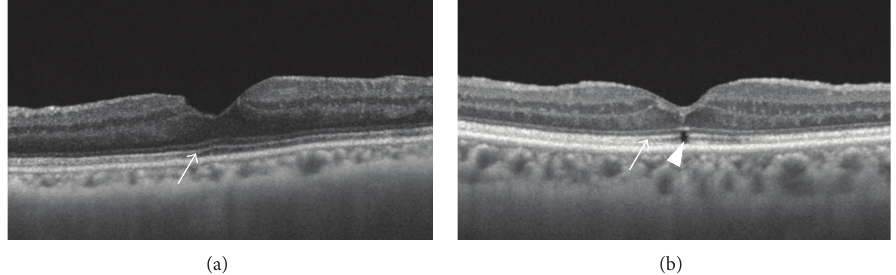
Figure2:MacularOCTimagesofsubjectsinGroupsA(a)andB(b).(a)TheEZ(arrow)hasbeenrestoredandcontinuous.(b)TheEZdisrup- tion (arrowhead) remains.